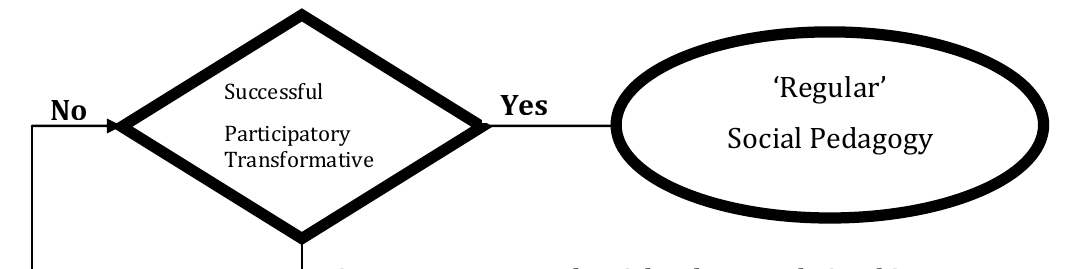
Figure II. PaTraPe and social pedagogy